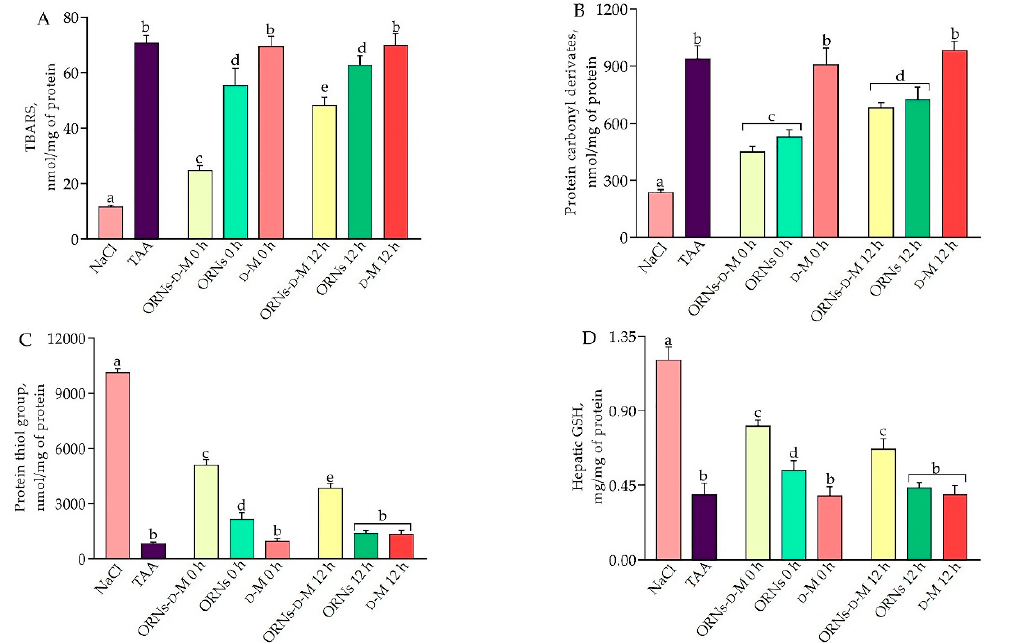
Figure 3. Effects of ORNs- D -M, ORNs and D-M on the levels of thiobarbituric acid reactive substances (TBARS) ( A ), protein carbonyl derivatives ( B ), protein thiol groups ( C ) and glutathione (GSH) ( D ) in TAA-induced liver damage mice. Data are presented as the mean ± SD, n = 6 for each group. Values marked with different letters (a, b, c, d, e) are statistically different, p < 0.05 (Student’s t -test).